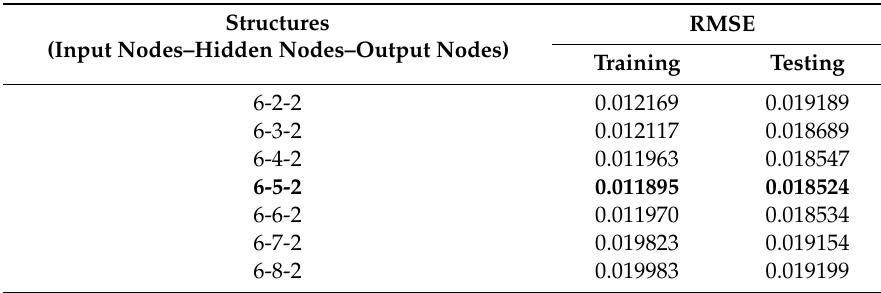
Table 1. The neural network (NN) architecture options.